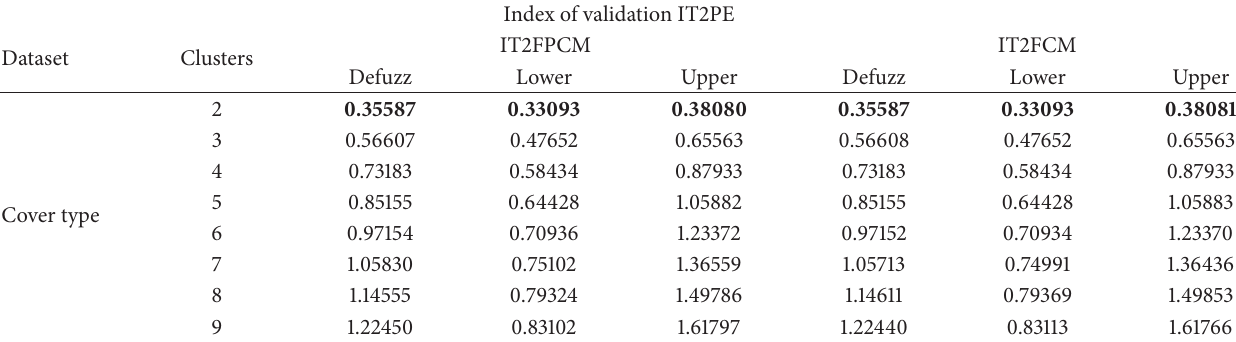
Table 22: Results of the IT2PE validation index to Cover type dataset clustering using IT2FPCM and IT2FCM algorithm with 𝑚 = [1.5, 2.5] and 𝜂 = [1.5, 2.5] as parameters.